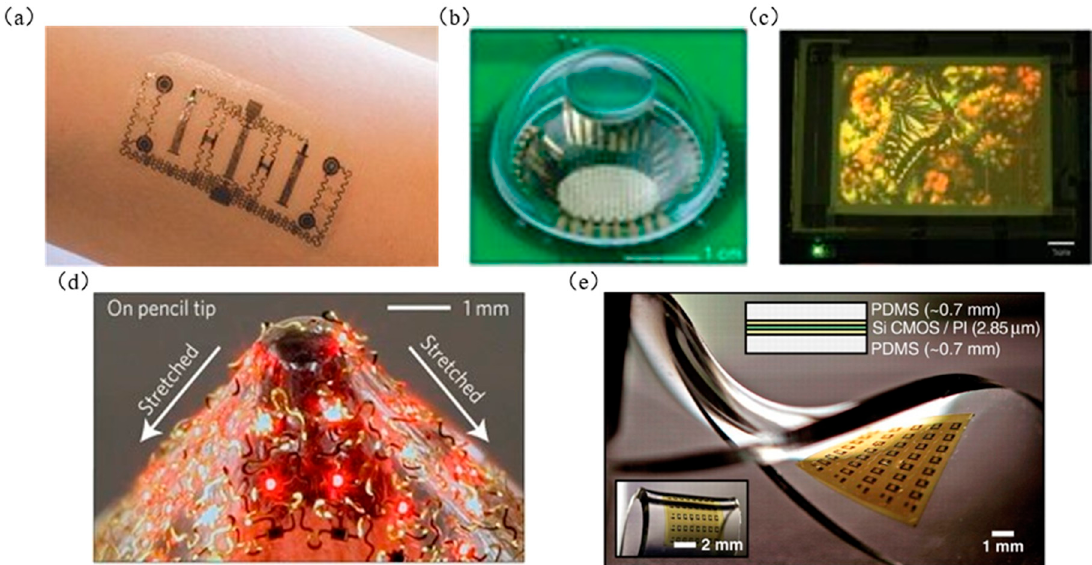
Figure 1. Examples of flexible electronics: ( a ) electronic skin (reproduced from [49]), ( b ) flexible bionic electronic eye, (reproduced from [50]), ( c ) flexible display (reproduced from [51]), ( d ) optical image of AllnGaP μ -lLEDs (6 × 6) array transferred to PDMS substrate and stretched on the pencil (reproduced from [52]), and ( e ) stretchable and foldable Si-CMOS circuit (reproduced from [53]).